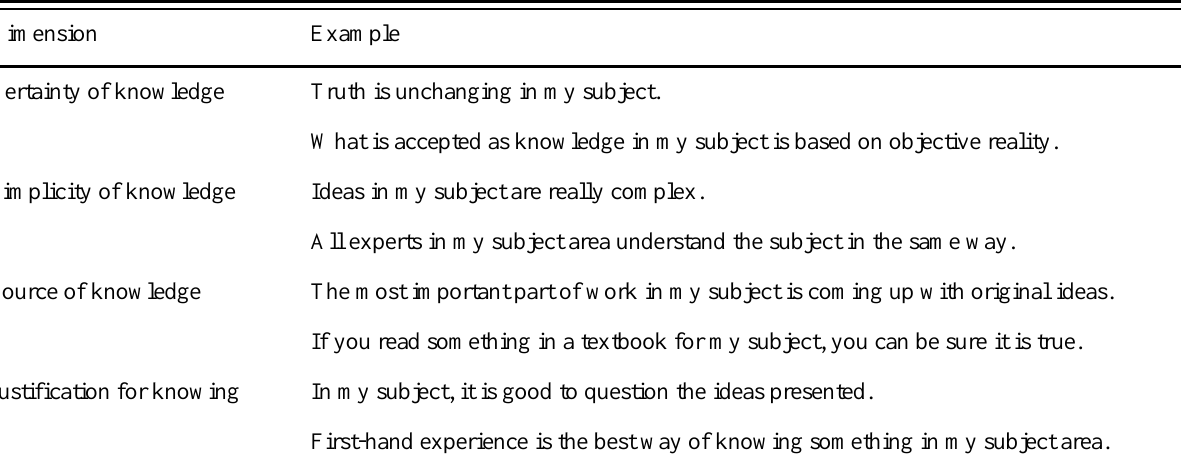
Table 8 . Examples of statements used in the PEB questionnaire against which students expressed the extent to which they disagreed or agreed on a 1-5 scale likert